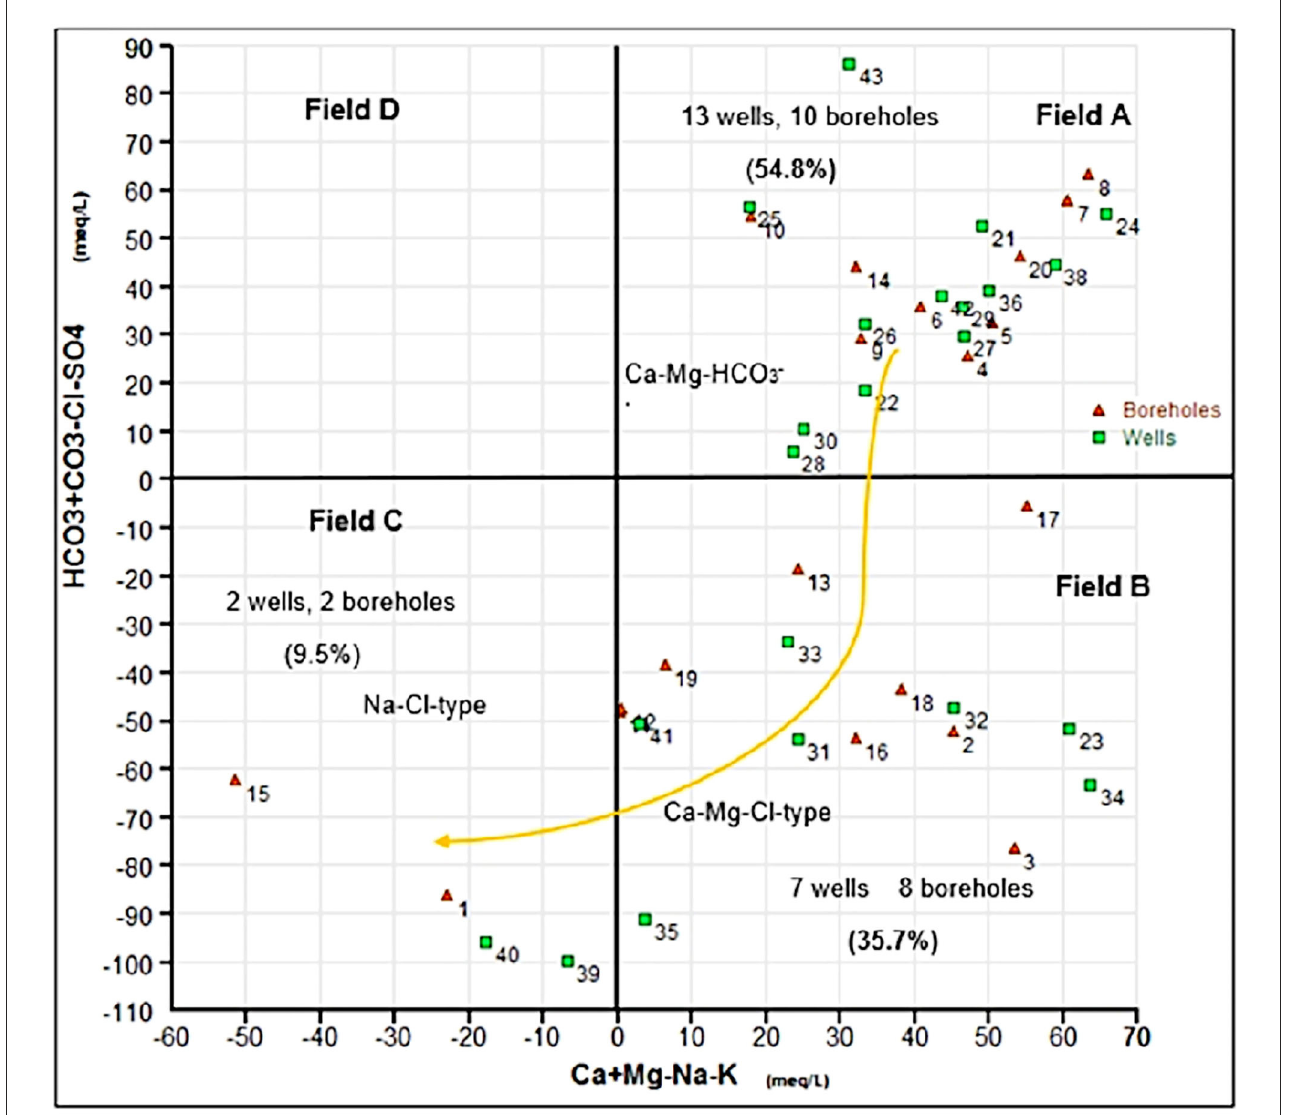
FIGURE5 Chadha’s diagram of the groundwater